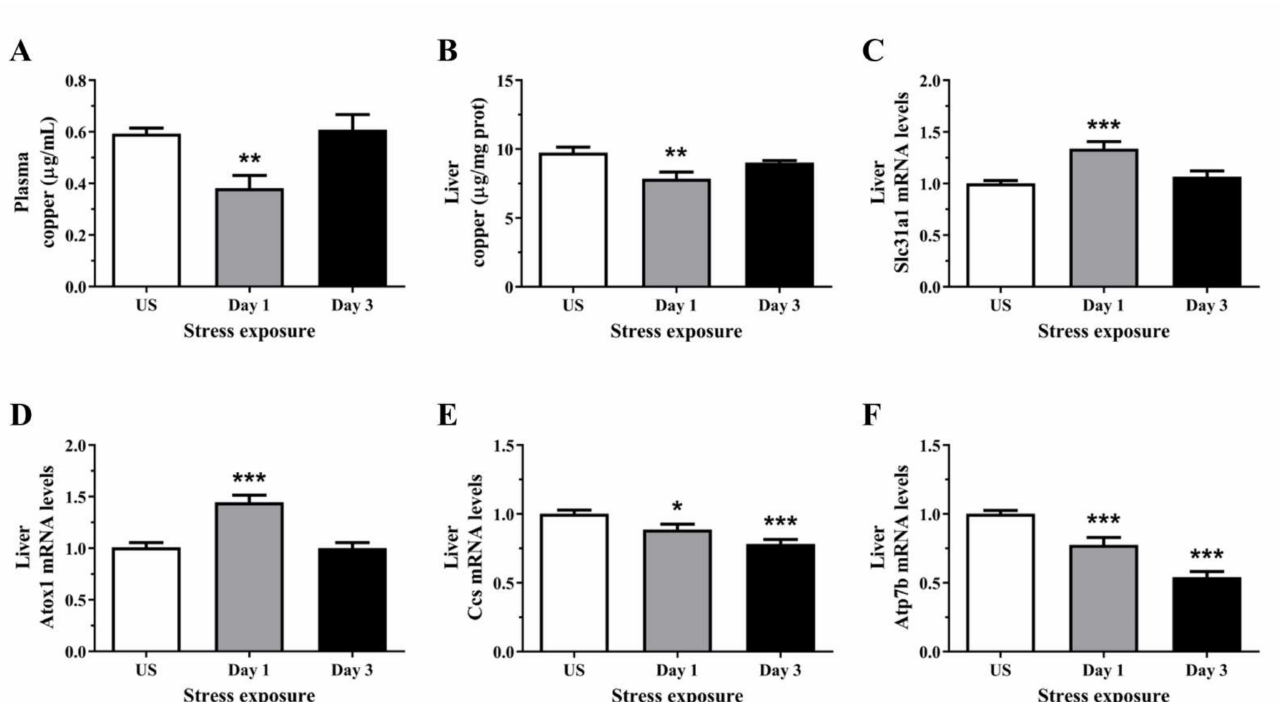
Figure 2. The effects of acute (Day 1, single 6 h) and repeated (Day 3, 6 h/day) restraint stress on ( A ) plasma copper, ( B ) liver copper, and hepatic ( C ) solute carrier family 31 member 1 (Slc31a1; Ctr1), ( D ) antioxidant 1 copper chaperone (Atox1), ( E ) copper chaperone for superoxide dismutase (Ccs), and ( F ) ATPase copper transporting beta (Atp7b) mRNA expression compared to unstressed (US) rats ( n = 7–8/group). Results were analysed using one-way analysis of variance (ANOVA) with Fisher’s least significant difference (LSD) test. Data are expressed as mean ± SEM, * p < 0.05, ** p <